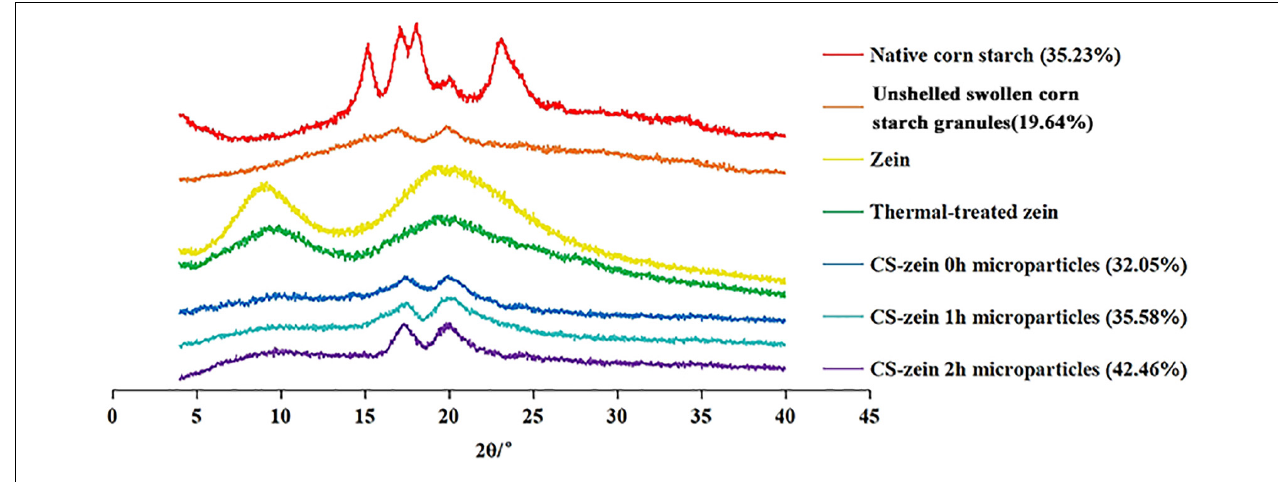
FIGURE 5 | X-ray diffractogram of native corn starch, unshelled swollen corn starch granules, zein, thermal-treated zein and core-shell starch/zein microparticles crosslinked by TGase for different times (0, 1, and 2 h). The relative crystallinity is provided in